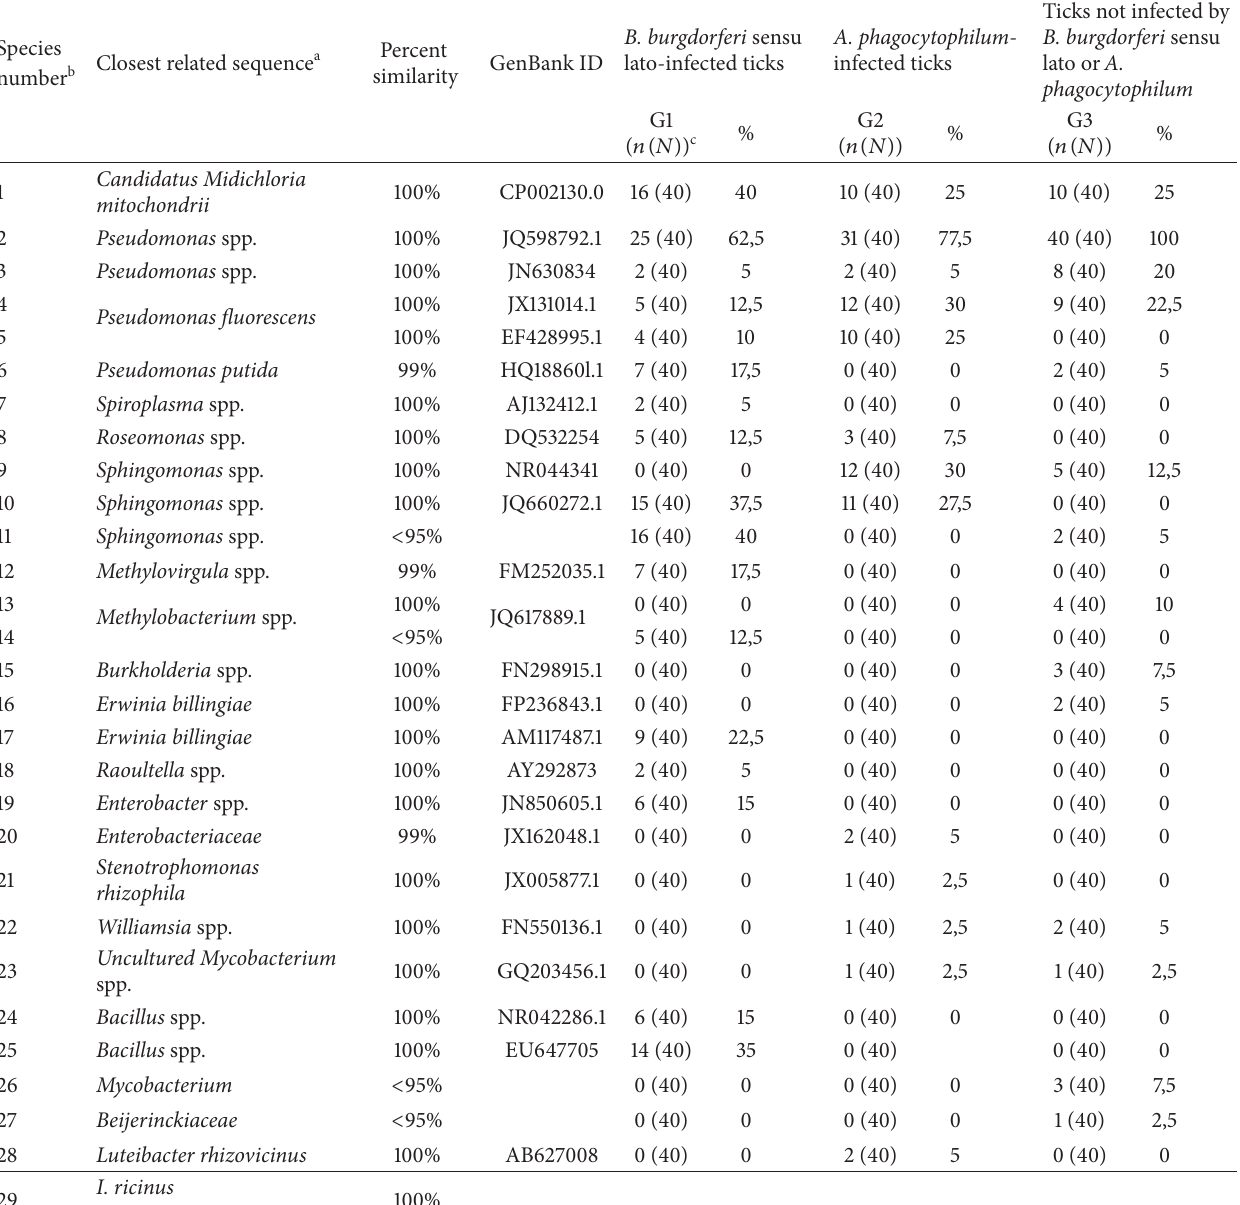
Table 2: Identification of bacteria associated with ticks obtained by sequence analysis of reamplified DGGE bands.